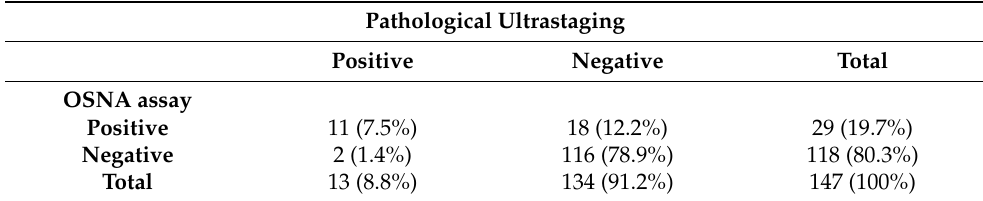
Table 3. Consistency between pathological ultrastaging analysis and